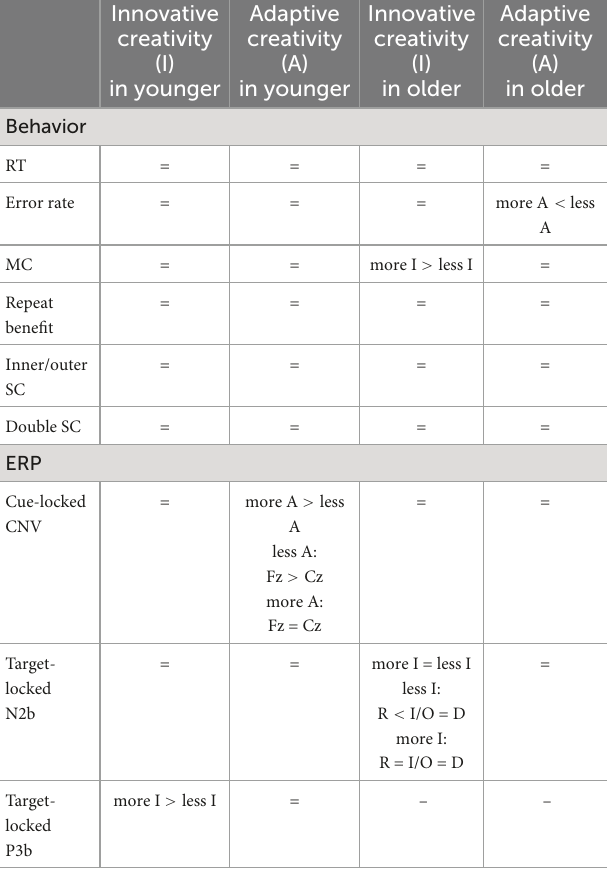
TABLE 5 Summary of our behavioral and event-related potential (ERP) results based on the applied age and creative-style grouping. Innovative